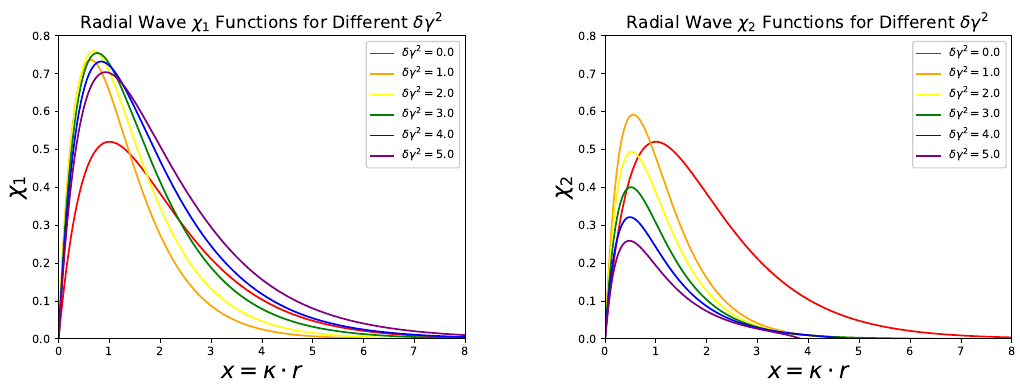
Figure 1 . Wave functions of the ground state for di(cid:11)erent (cid:14)(cid:13) 2 . Here we adopt c 1 = 0 : 35, c 2 = 1, (cid:24) 1 = 200, (cid:24) 2 = 100. We can see clearly that the (cid:31) 2 reduces as the (cid:14)(cid:13) 2 accumulates. Here we only plot the A > 0 case, and the wave functions are